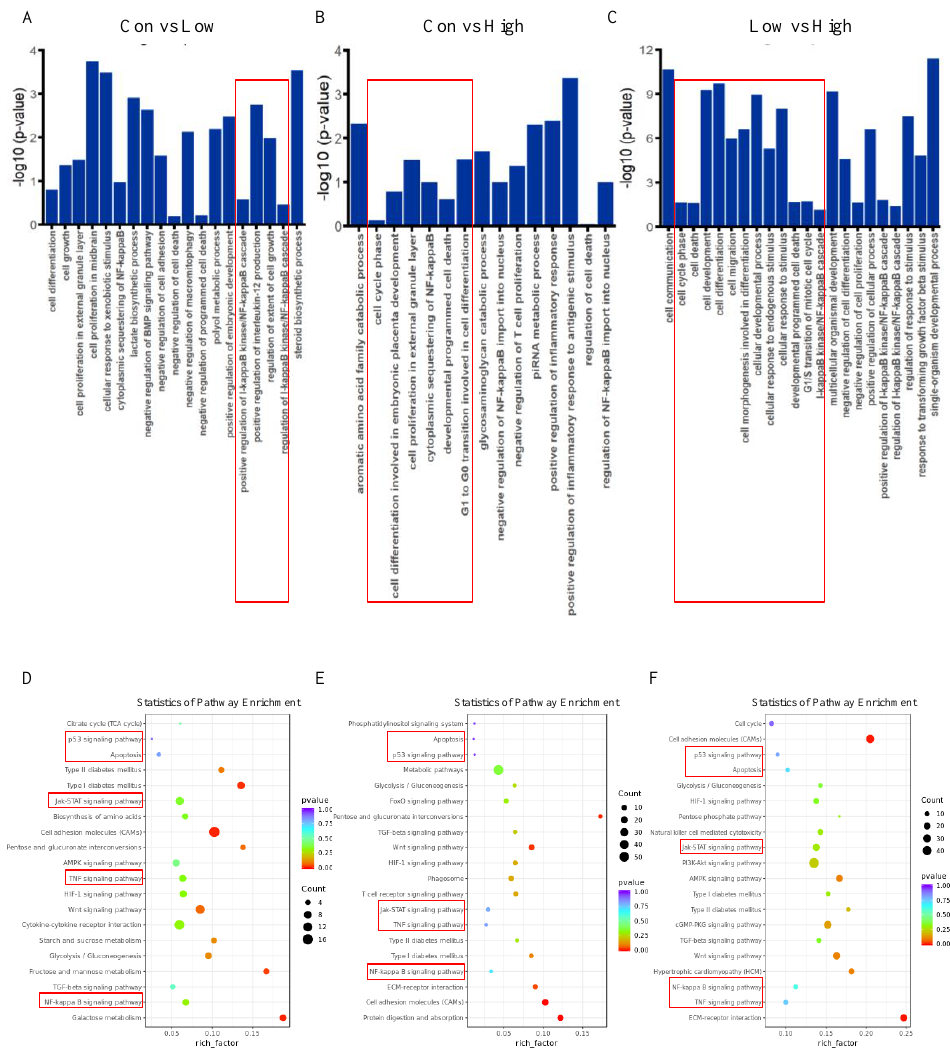
Figure 4. Gene Ontology (GO) and Kyoto Encyclopedia of Genes and Genomes (KEGG) Analyses of differentially expressed lncRNA target genes and mRNAs in GCs in different glucose treatment groups. ( A – C ) GO categories (biological process) of differential lncRNA target genes in different glucose treatment groups (CON versus LOW, CON versus HIGH and LOW versus HIGH). ( D – F ) KEGG analysis of differential lncRNA target genes in different glucose treatment groups. The size and color of each bubble represents the number of genes in each pathway and p value, respectively.